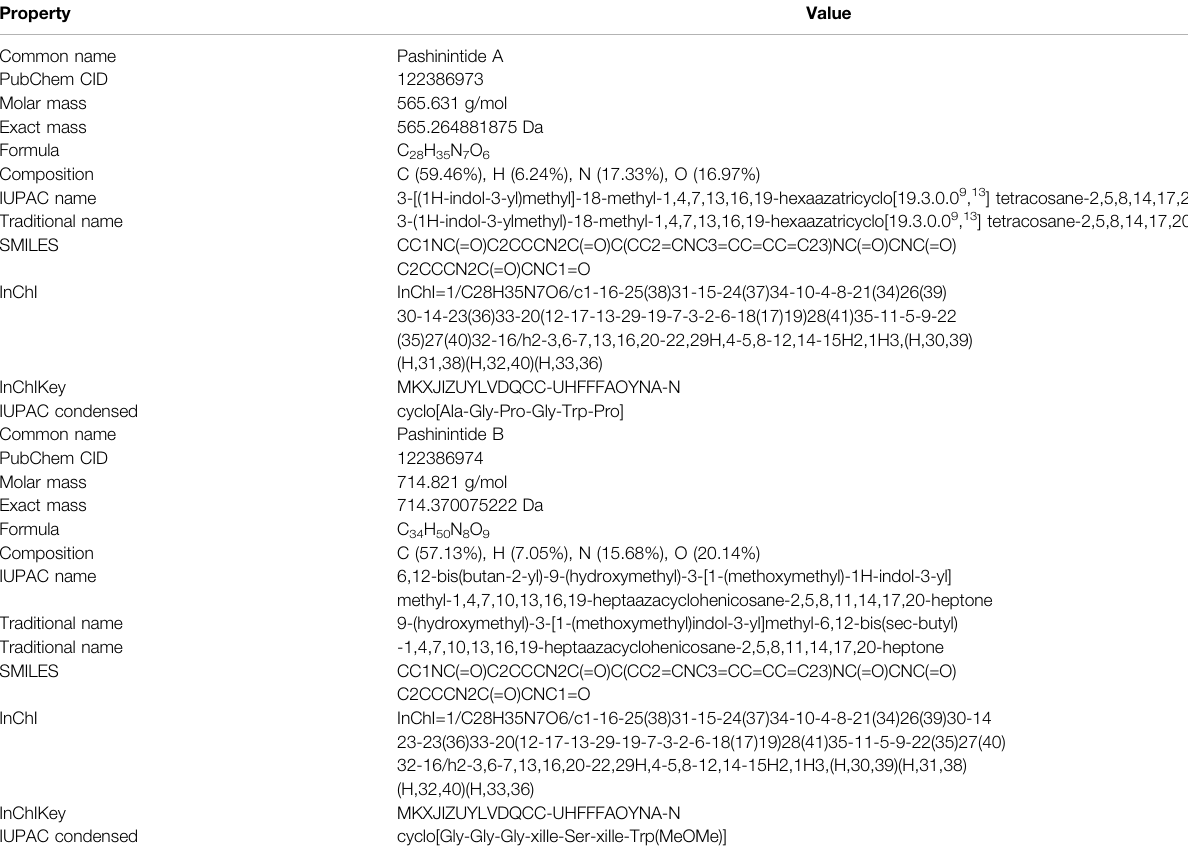
TABLE 1 | Names, identi fi ers, molecular fi ngerprints and basic properties of the studied molecular systems.